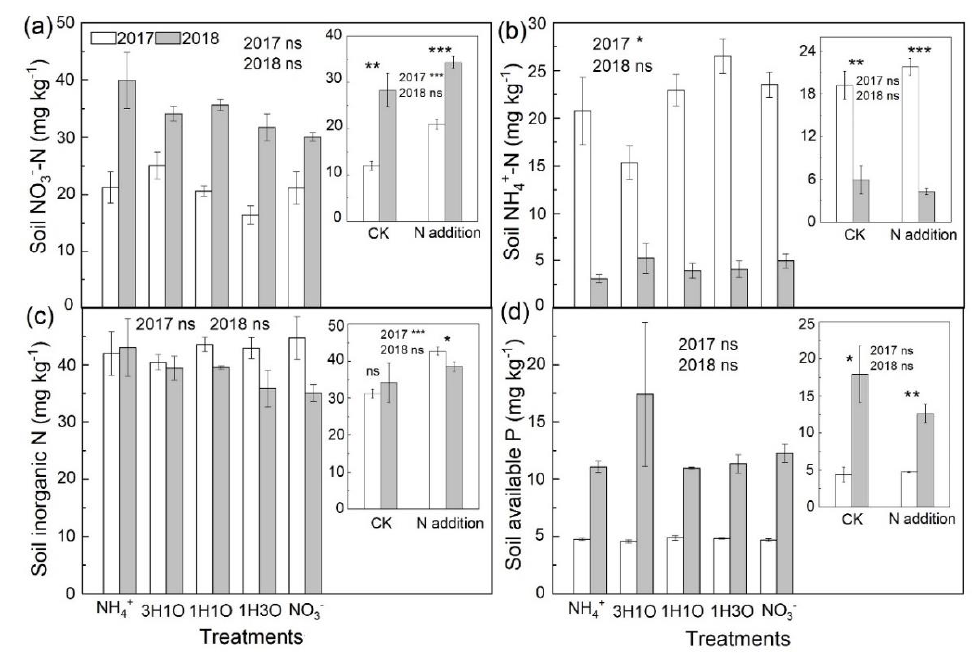
The F-values with the level of significance presented. NO 3 − -N represents soil nitrate N, NH 4+ -N represents soil ammonium N, IN represents soil inorganic N, AP represents soil available P, Ng and Pg represent N and P concentrations in green leaves, respectively; Ns and Ps represent N and P concentration in senesced leaves, respectively; NRE and PRE represent N resorption efficiency and P resorption efficiency, respectively. * p < 0.05; ** p < 0.01; *** p < 0.001.